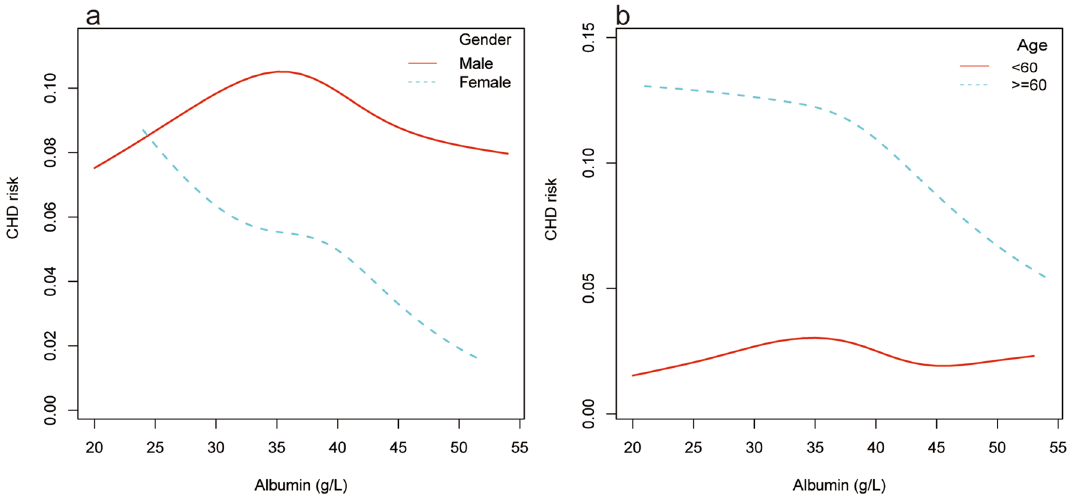
Figure 3. The relationship between serum albumin and coronary heart disease risk stratified by age and gender. Adjust for: gender, age; race, diabetes, HDL-C, hypertension, LDL-C, creatinine. When gender or age was the hierarchical variable, it were not adjusted.